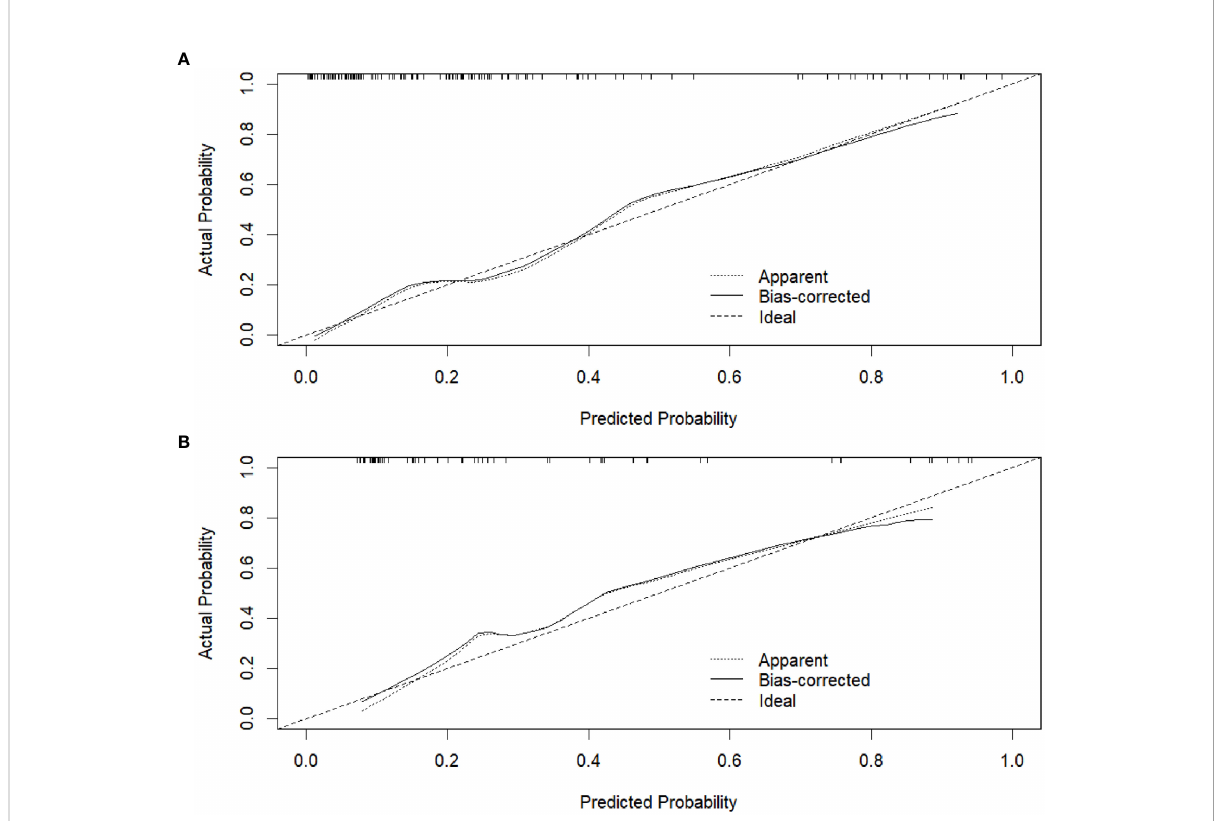
FIGURE 6 Calibration curves of the radiomics nomogram in the training dataset (A) and validation dataset (B) ,